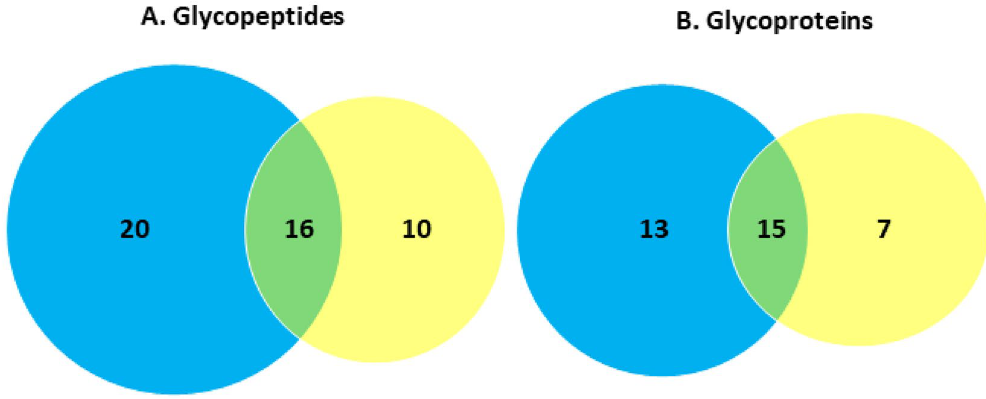
Figure 6. Overlap of C. hepaticus glycopeptides ( A ) and glycoproteins ( B ) identified using FAIMS (blue) and ZIC-HILIC (yellow) enriched samples. Combined, 46 glycopeptides from 35 glycoproteins were identified.